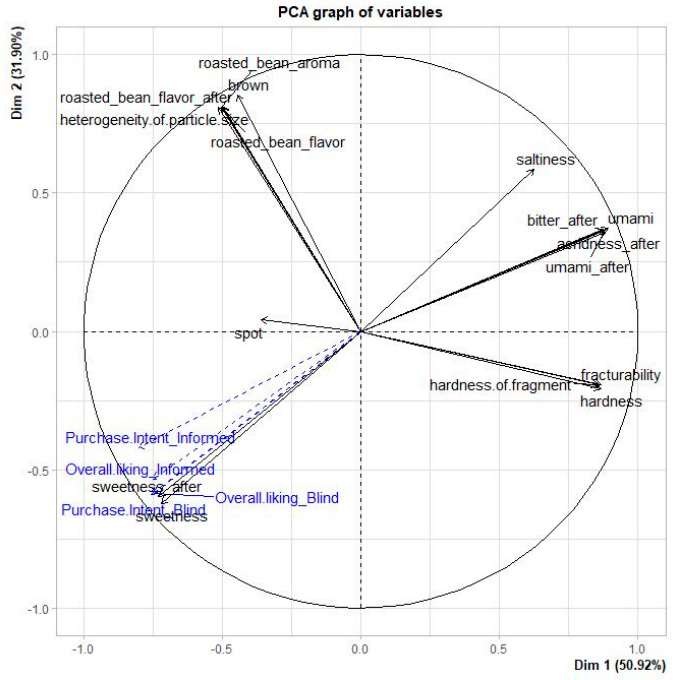
Figure 4. Drivers of liking depending on the information